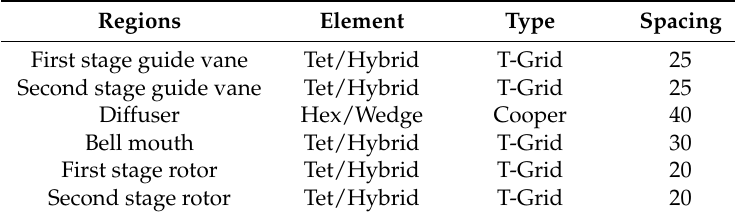
Table 2. The details of the mesh in the different